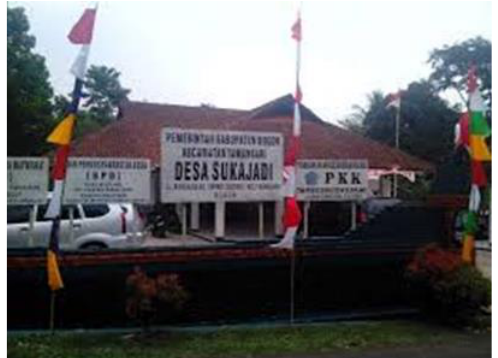
Figure 3. Sukajadi Village Office, Bogor Regency